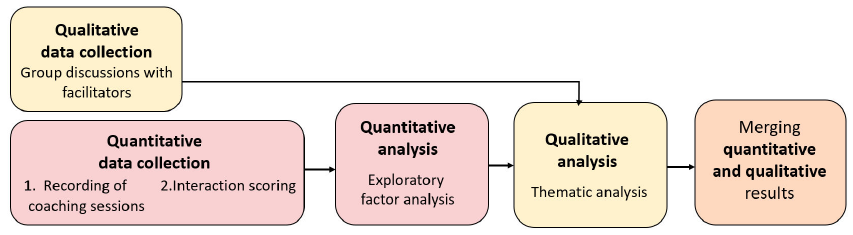
Figure 1. Mixed methods study